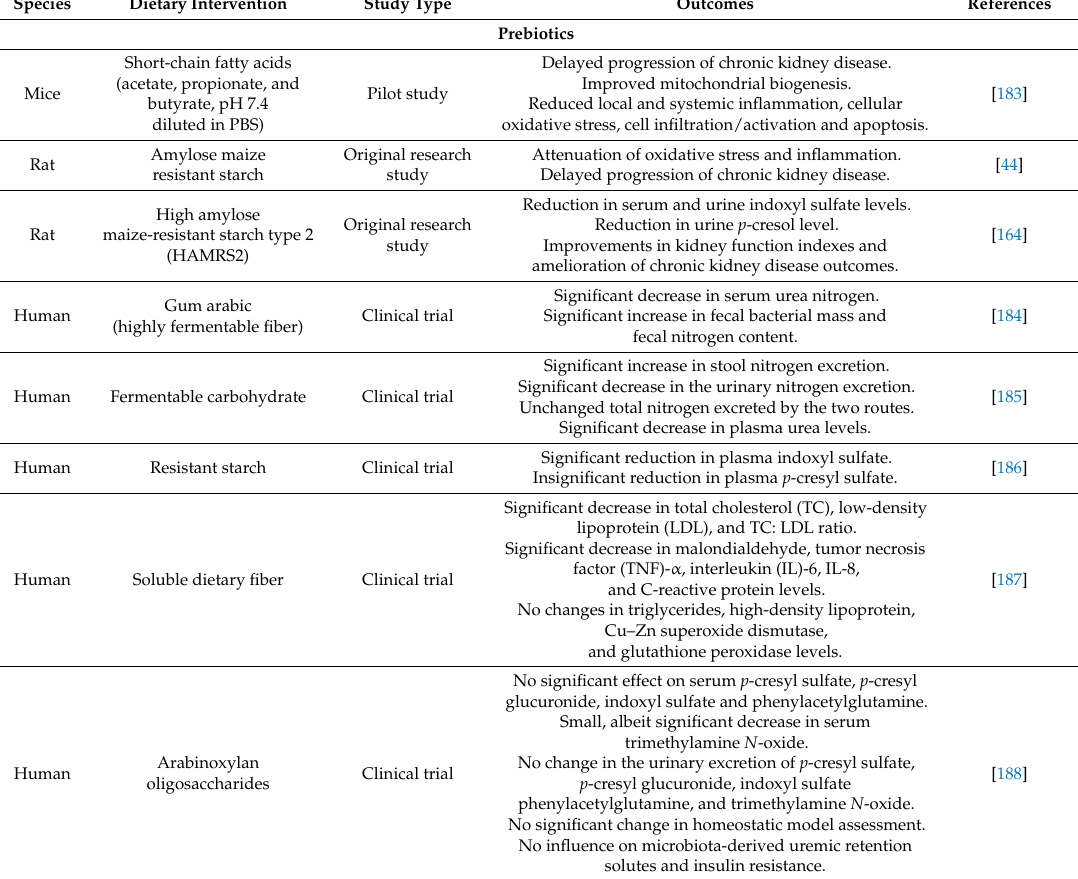
Table 1 is a summary of animal and human investigations of prebiotics/probiotics in CKD. Table 1. Studies that examined prebiotics and/or probiotics in patients or animals with chronic kidney